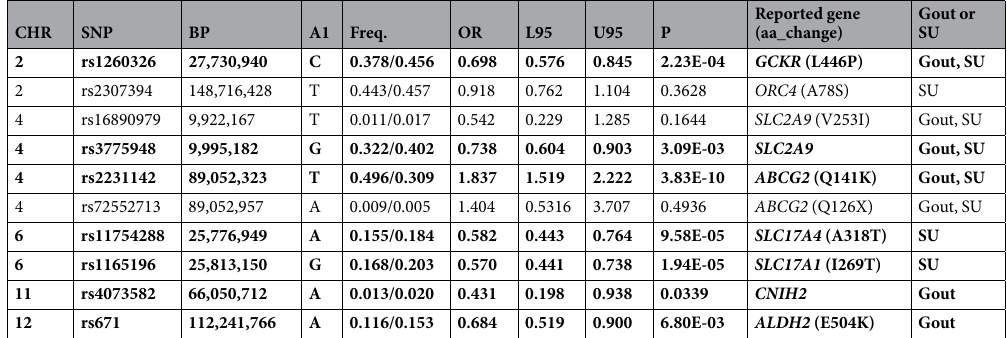
Table 2. Association results for the selected important variants. CHR, Chromosome; SNP, dbSNP rs number; BP, Position, based on hg19; A1, minor allele for the whole sample; Freq., frequency of A1 for cases/controls; OR, odds ratio, for A1; L95, the lower endpoint of the 95% confidence interval (CI); U95, the upper endpoint of the 95% confidence interval; P, p value. Reported gene(s), The reported gene(s) in the previous GWAS; aa_change, amino acid change; Gout or SU, indicating whether the locus found to be associated with gout or SU; The variants with p < 0.05 were indicated in bold. All the OR (95% CI) and p values reported in this study were based on the PCA adjustment